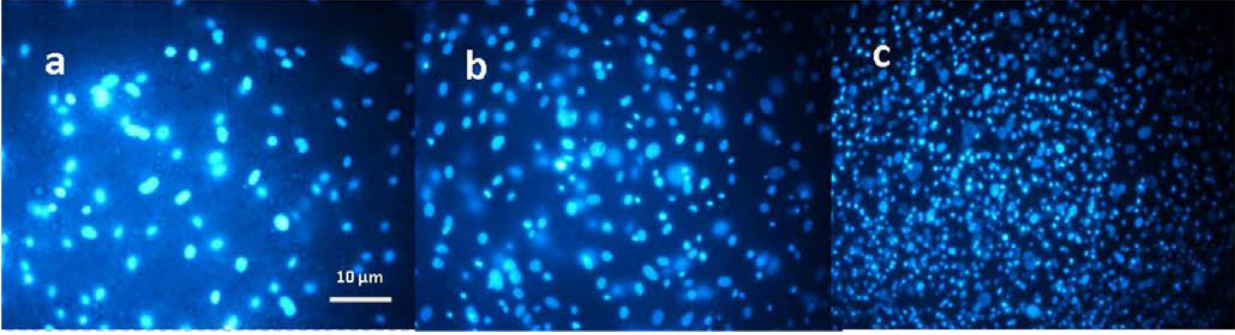
Figure 7. Images of nanofibrous scaffolds with inoculated cells stained with DAPI: ( a ) without modification, ( b ) modified with GO , ( c ) modified with rGO. Reproduced with permission [94] © IOP Publishing.